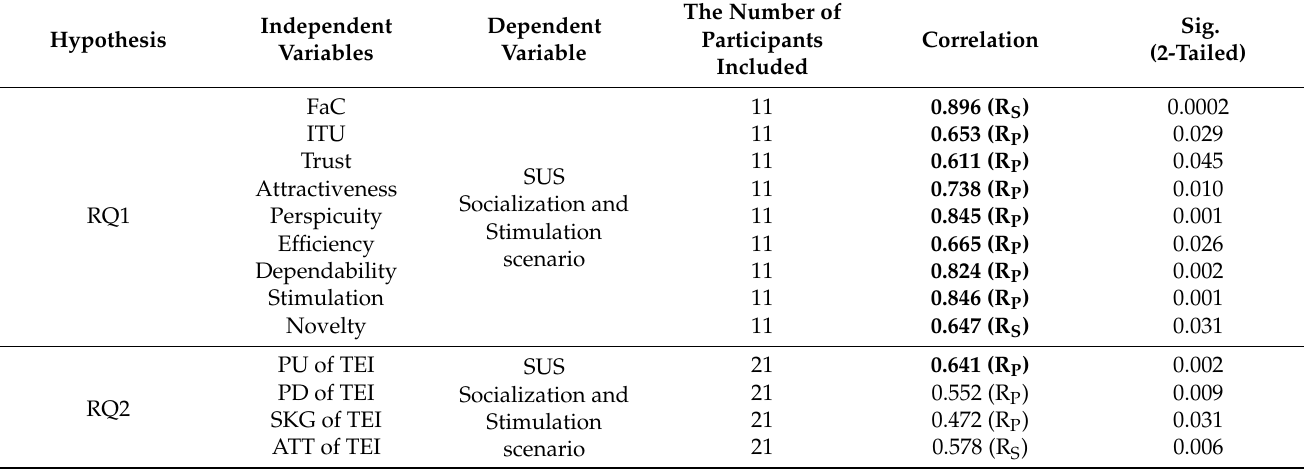
Table A7. Correlation